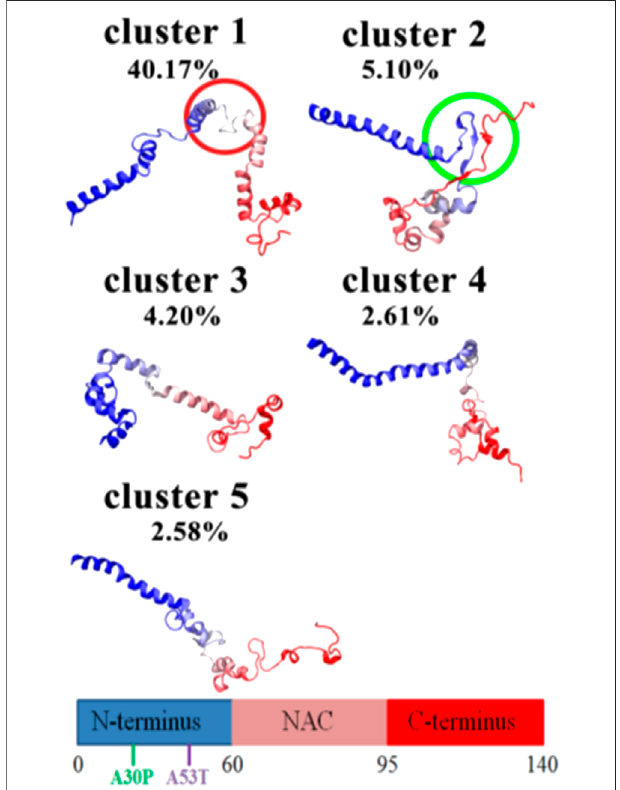
FIGURE 4 | MD WT monomeric aSyn models. Centroid from the most relevant conformational clusters. This fi gure has been reproduced upon copy right permissions (Yu et al.,